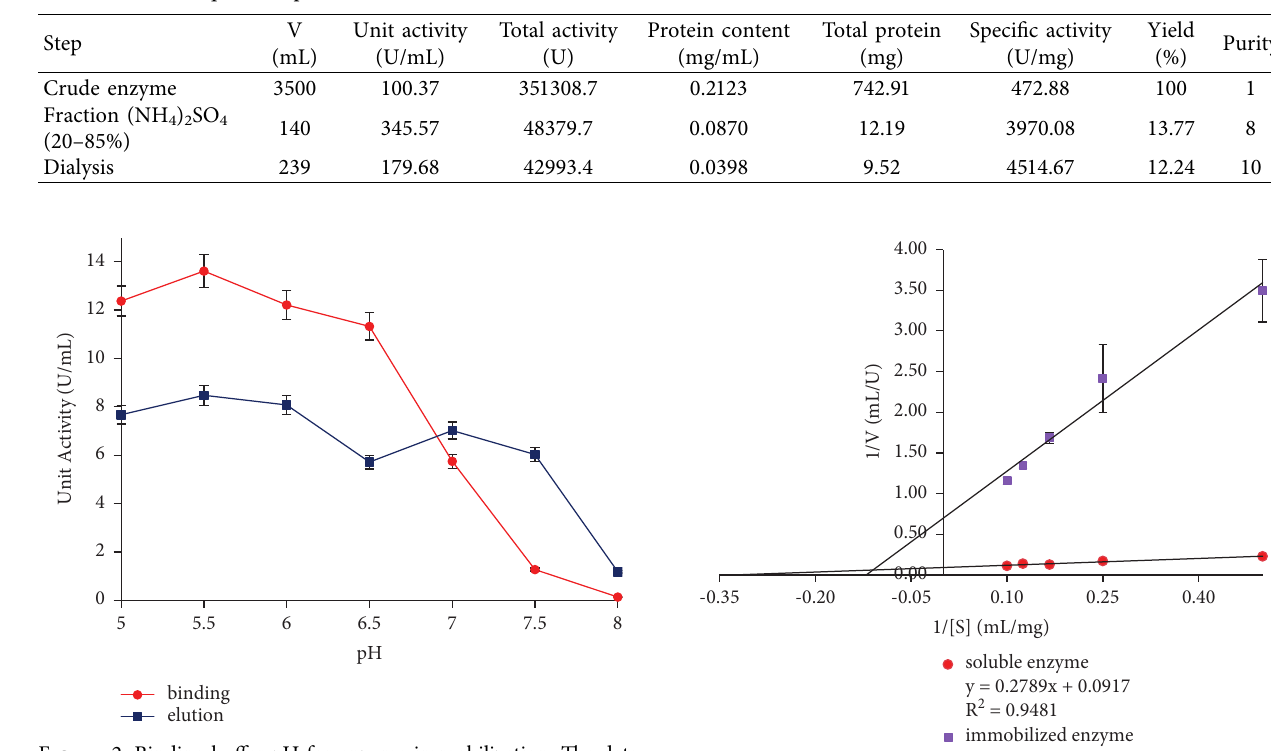
Table 1: Summary of partial purification procedures of α -amylase from A. fumigatus unit activity was determined with 0.1% soluble starch as a substrate in aquadest ( pH ± 6 . 5 ) at 60 ° C for 10min.